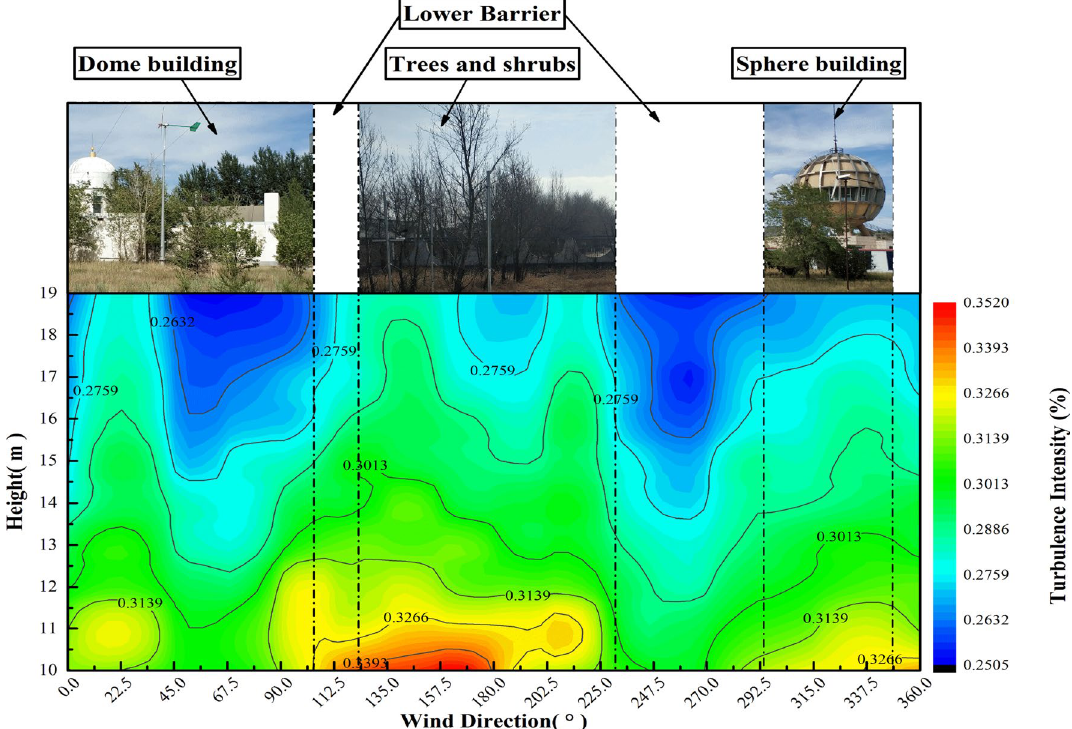
Figure 22. 10–19 m TI is distributed by wind direction throughout the year at all observed